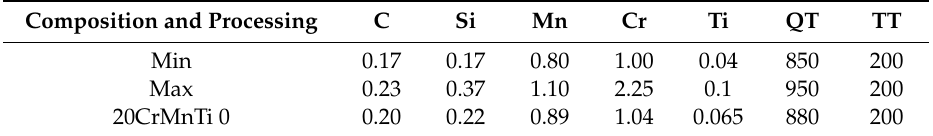
Table 7. Composition design input range.